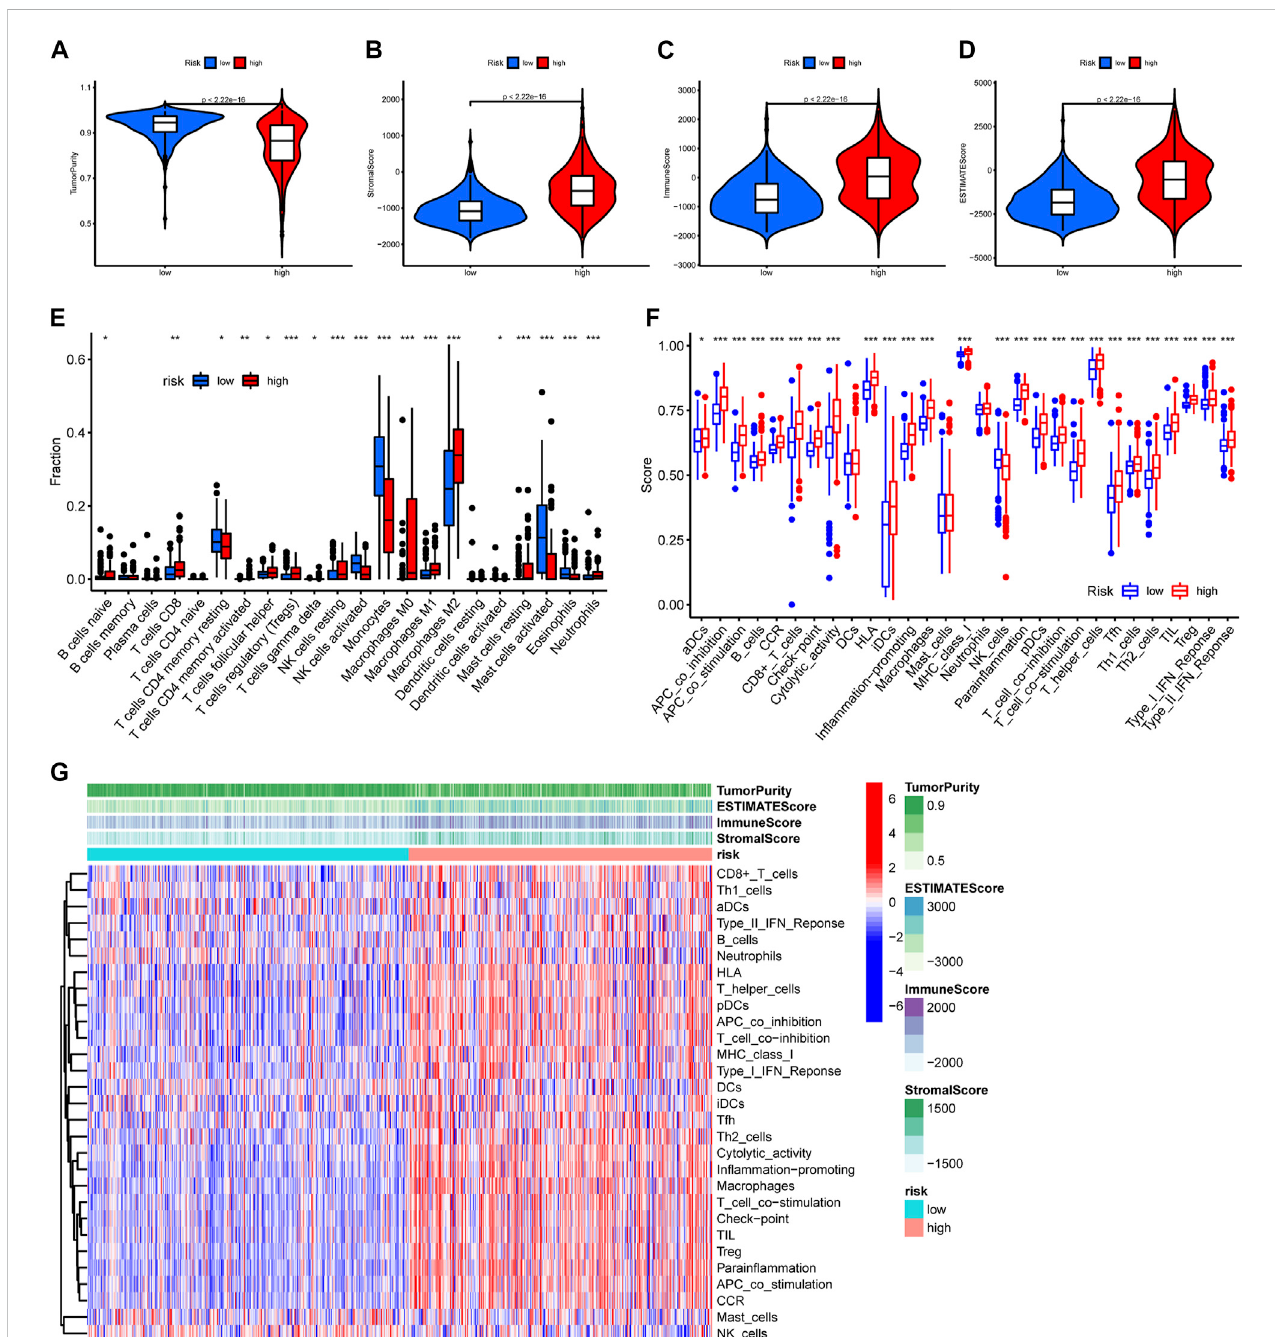
differences of immune-function-related gene sets between high- and low-risk group glioma samples. (G) Heatmap exhibiting the immune function enrichment alteration between different risk group glioma samples. *: p < 0.05, **: p < 0.01, ***: p <